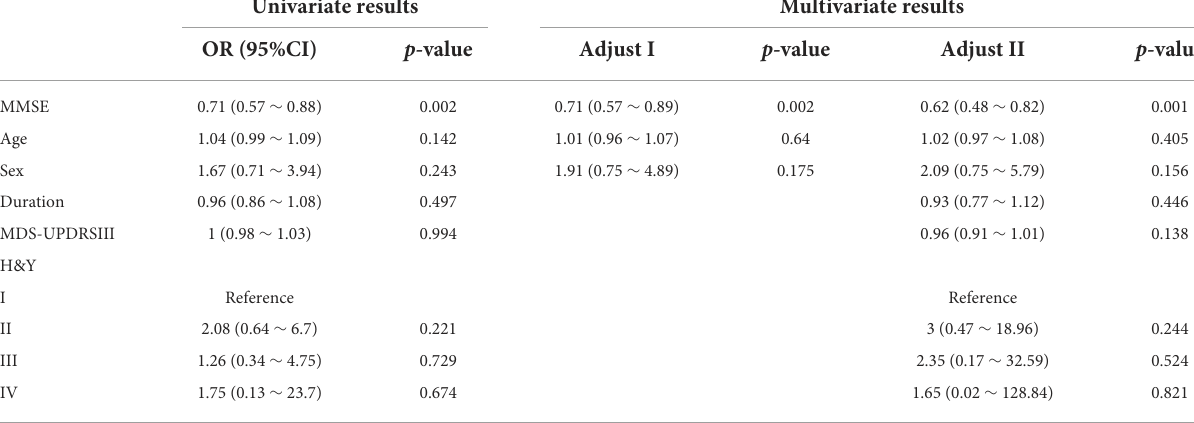
TABLE 5 Univariate and multivariate analysis for the association between latency and possible factors. Univariate results Multivariate results